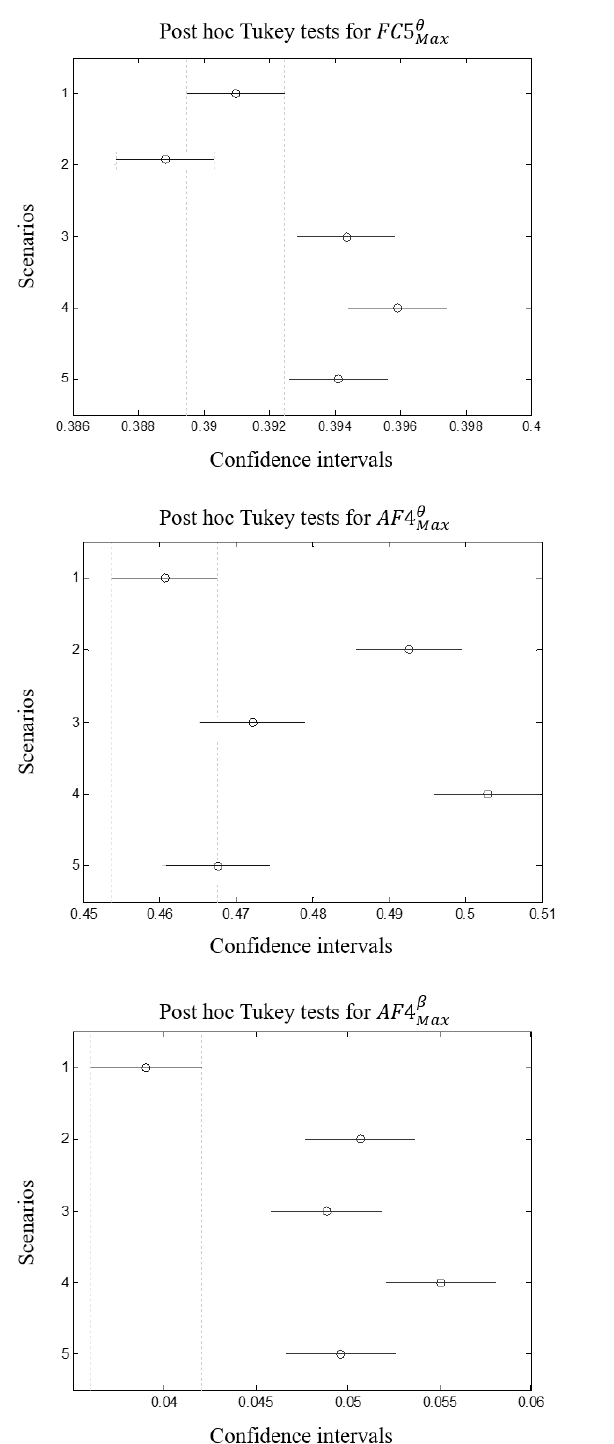
Figure 11. From left to right: differences between scenarios reported by Tukey tests for FC 5 θ AF 4 α , AF 4 β , AF 4 γ Max Max Max